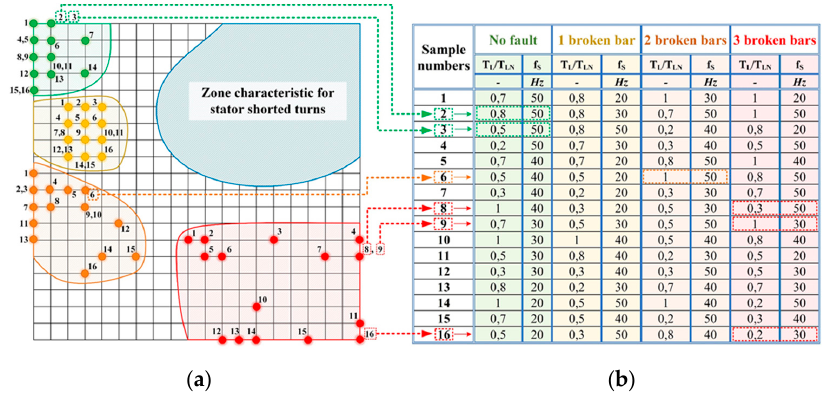
Figure 11. Classification of the rotor cage damage of the induction motor: ( a ) Kohonen map (20 × 20): solid lines—IM damage categories involved in the classification, hatched areas—IM damage categories not involved in the classification; ( b ) specification of test data parameters; T L —load torque, T LN —rated motor torque, f s —frequency of the supply voltage.